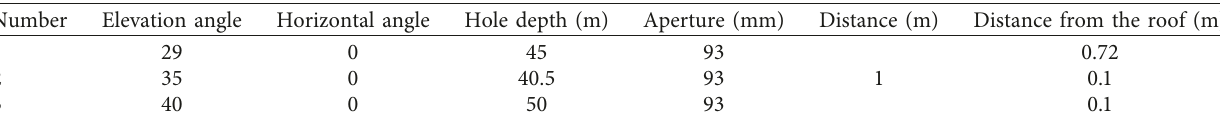
maximum occurred at 10 m on the left side of the air return roadway. Under the influence of air return roadway, the stress variation displayed hump shape. In the middle part of